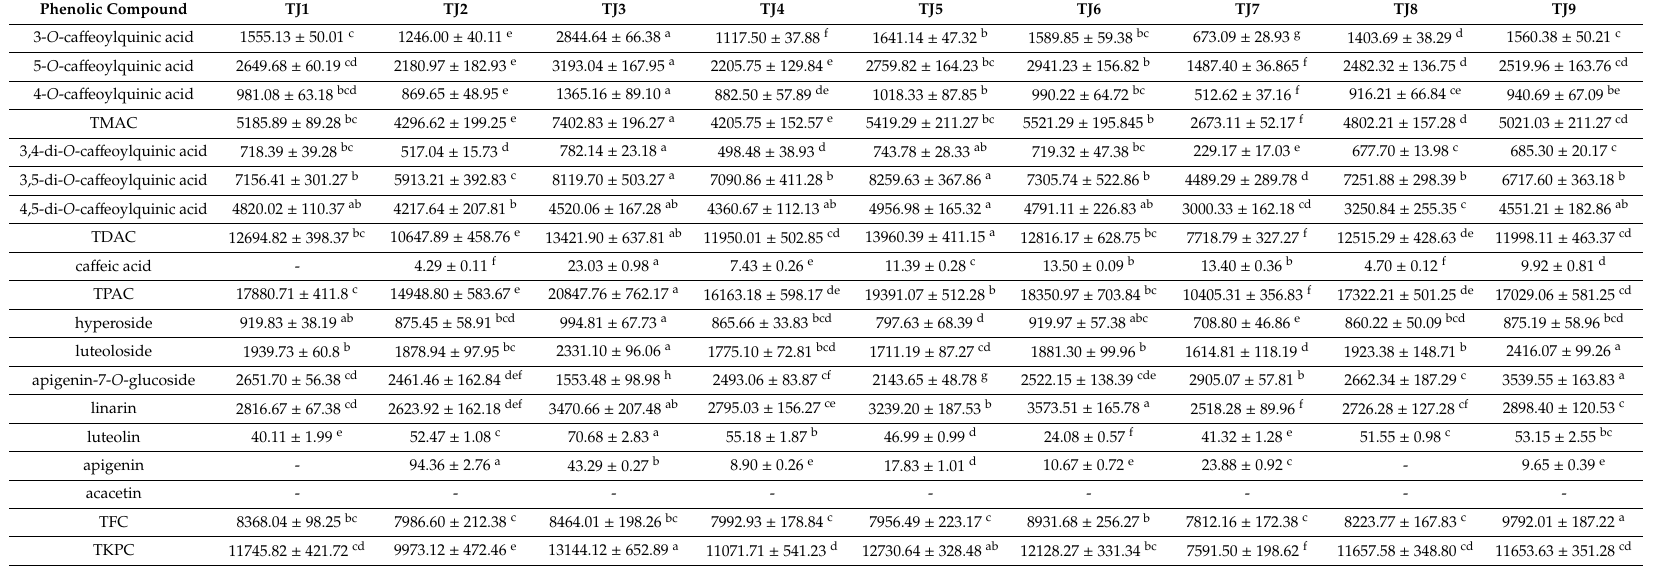
Table 2. Contents of phenolic compounds in di ff erent ‘Taiju’ ( µ g / g